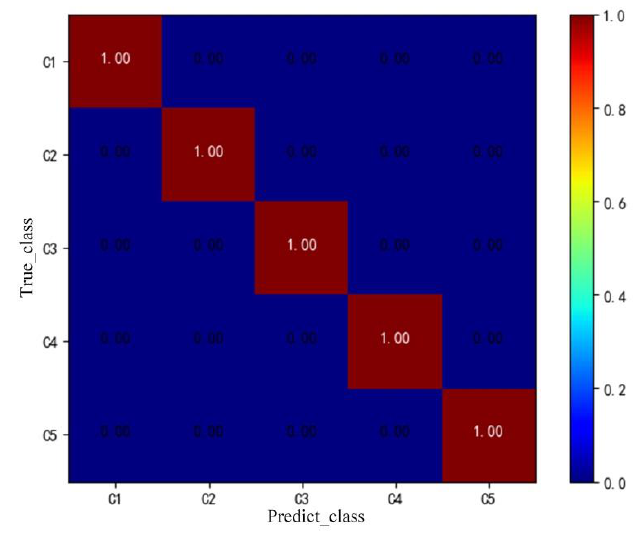
Figure 9. Confusion matrix.